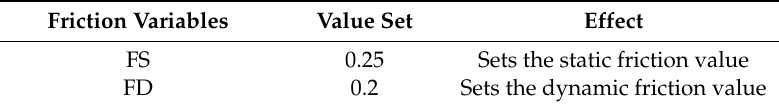
Table 6. Contact friction values.